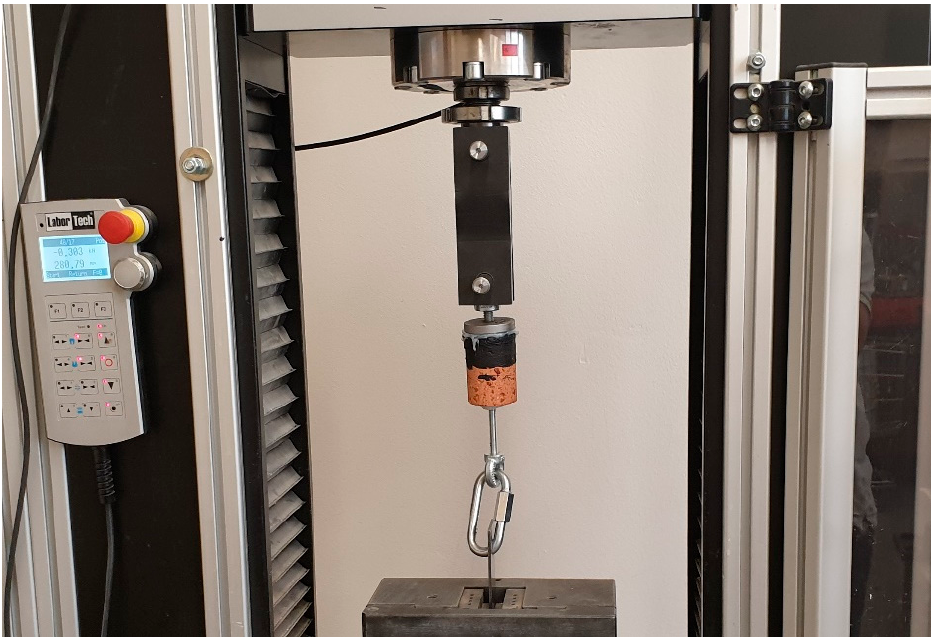
Figure 10. Test specimen prepared for the tear-off test. Tear-off tests were performed with the electromechanical testing machine LabTest 4.100 ST1 (LaborTech s.r.o., Opava, Czech Republic). This testing machines made it possible to monitor and record the course of tensile stress in real time. The accuracy class is according to EN ISO 7500-1, ASTM